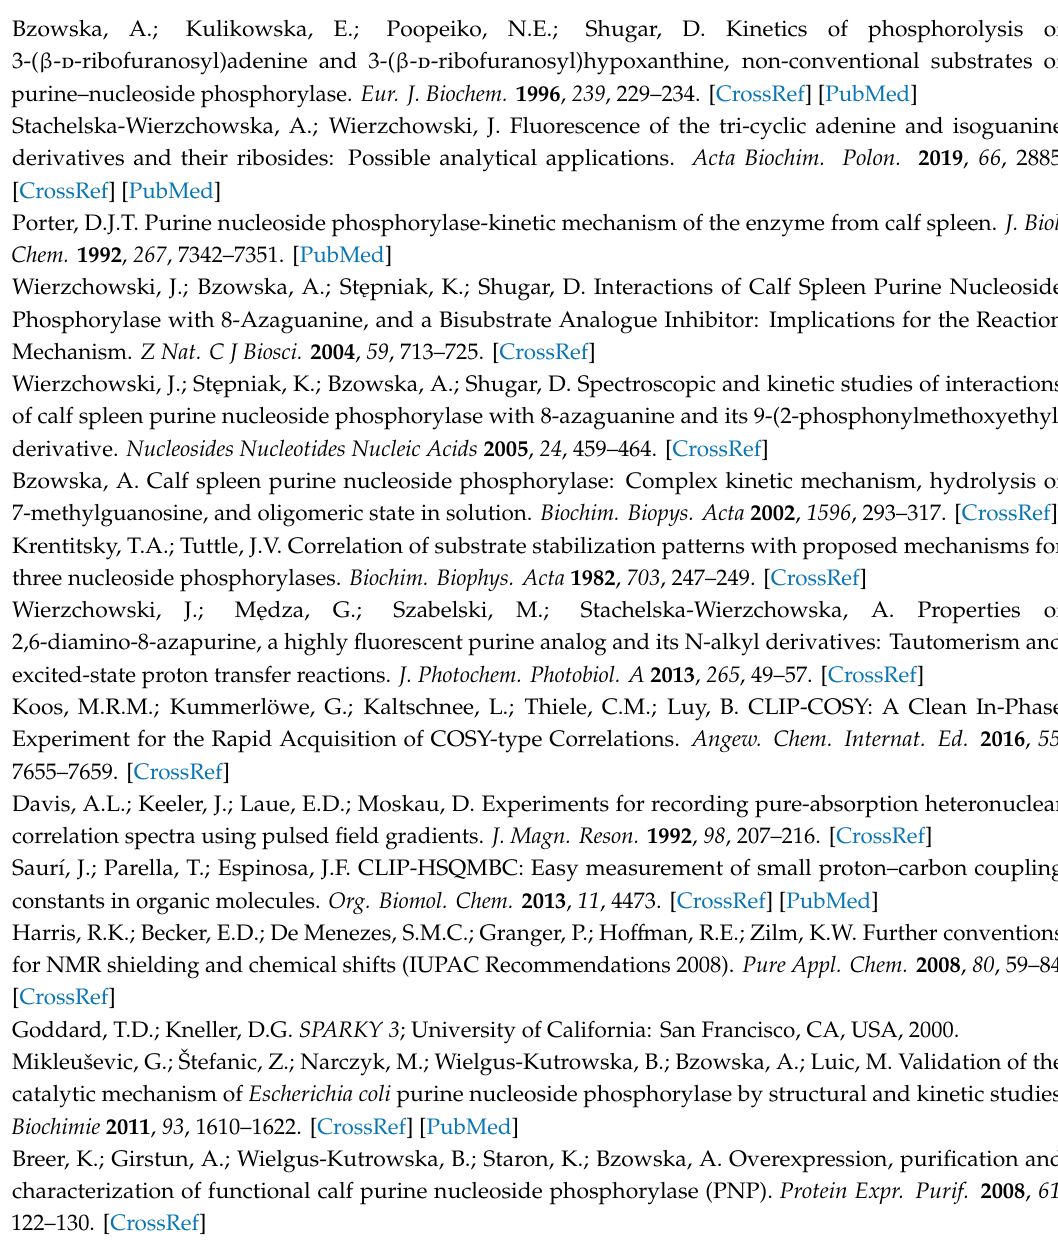
Sample Availability: Samples of the compounds 1,N 2 -etheno-2-aminopurine ( 1 ), N 2 ,3-etheno-2-aminopurine ( 2 ) are available from the